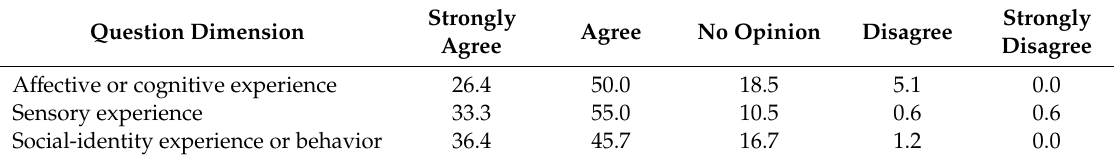
Table 21. Percentage statistics of the evaluation of the writers’ experiences from indicator viewpoints. Strongly Agree No Opinion Disagree Question Dimension Agree A ff ective or cognitive